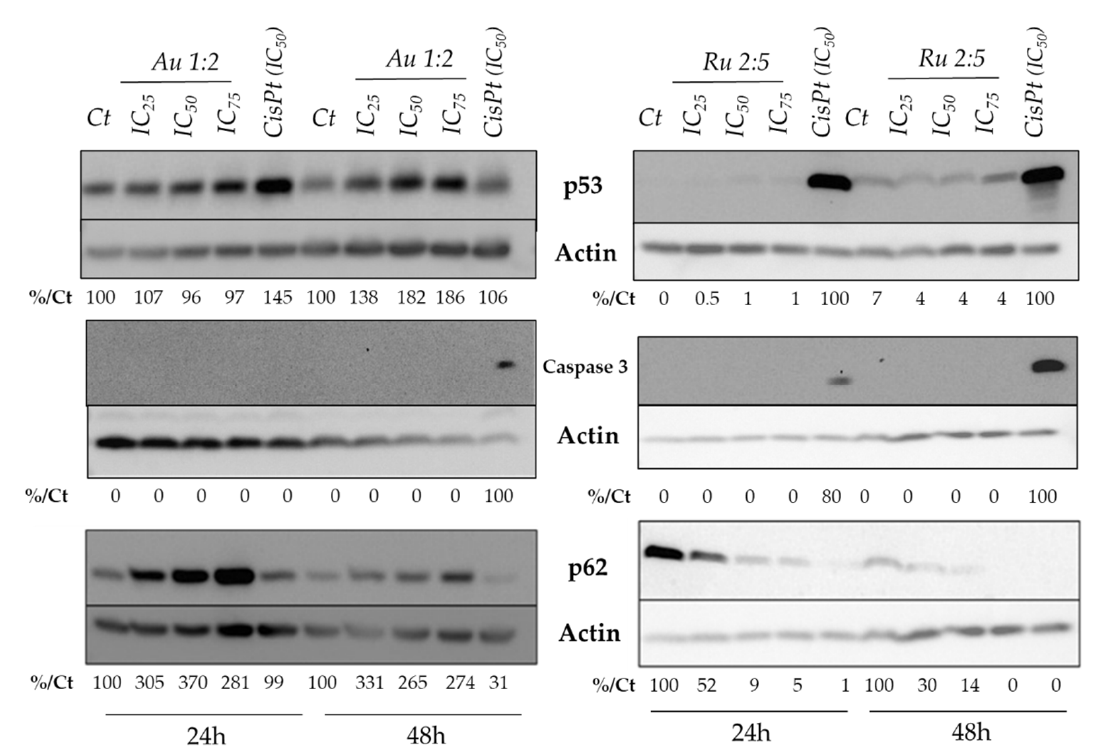
Figure 4. Expression of cleaved caspase-3, p53 and p62. Cisplatin was used as positive control (IC 50 ). IC 25 , IC 50 and IC 75 were utilized to treat the cells. This image is representative of three independent experiments. The expression of proteins in AGS cells for [Au(pipeDTC) 2 ]Cl and in HCT116 cells for [Ru 2 (pipeDTC) 3 ] is reported.